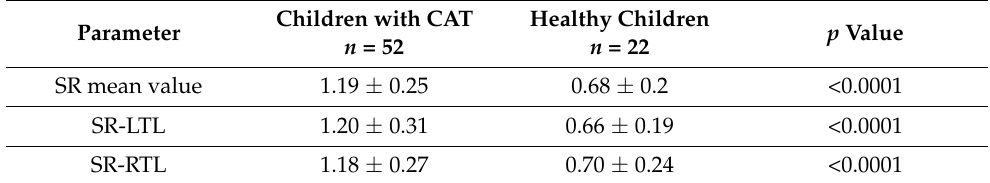
Table 2. Mean SR values in the two groups of children.